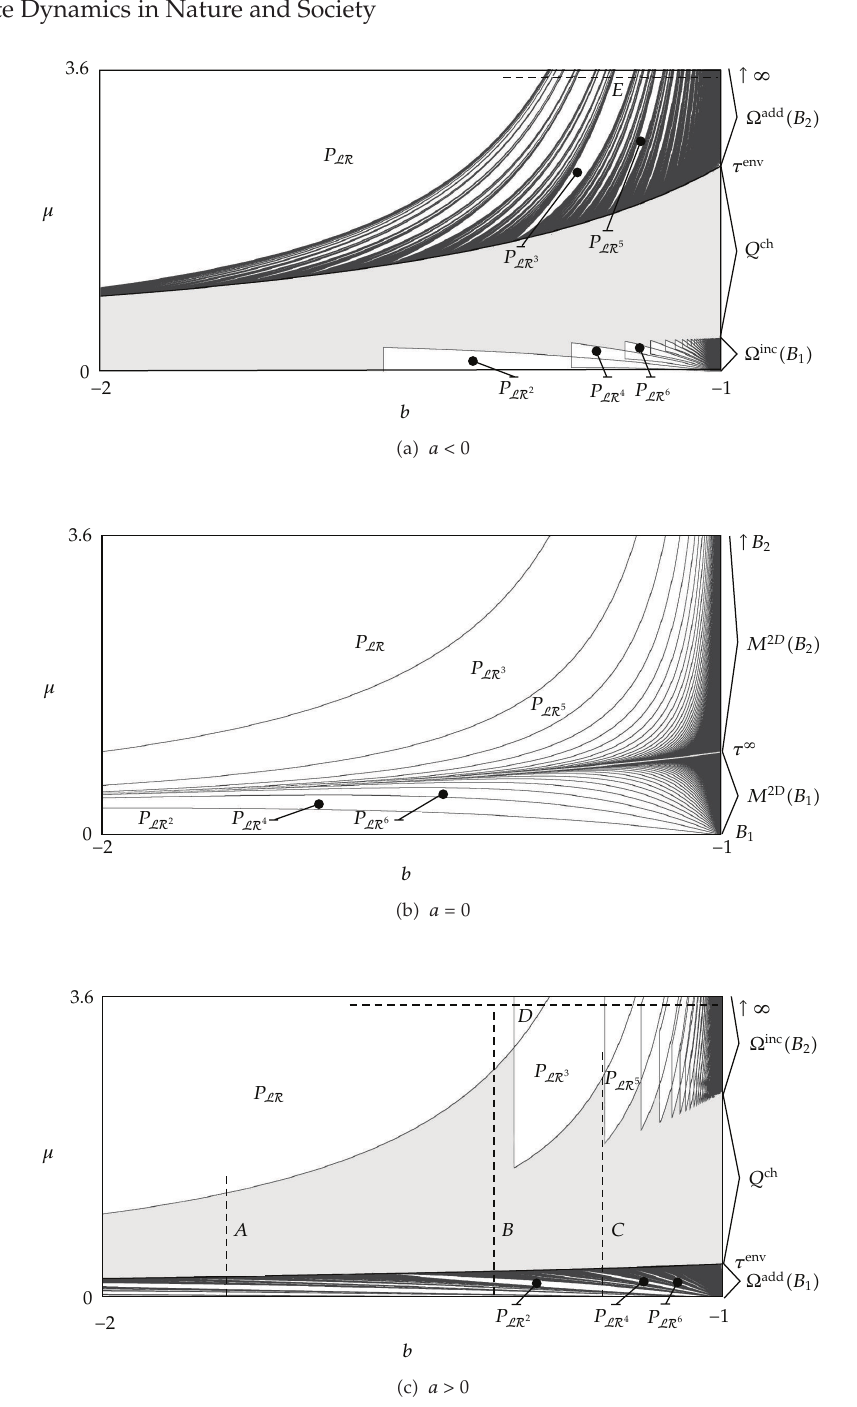
Figure 2: Numerically calculated bifurcation structures in the (cid:7) b,μ (cid:8) -plane for a (cid:6) − 0 . 42 (cid:7) a (cid:8) , a (cid:6) 0 (cid:7) b (cid:8) , a (cid:6) 0 . 42 (cid:7) c (cid:8) , and b (cid:6) − 2 . 0 ··· − 1 . 0, μ (cid:6) 0 ··· 3 . 6. The gray areas in (cid:7) a (cid:8) and (cid:7) c (cid:8) mark the chaotic domain Q ch . The dashed lines in (cid:7) a (cid:8) and (cid:7) c (cid:8) show the locations of the bifurcation scenarios, shown in Figures 1, 3, and